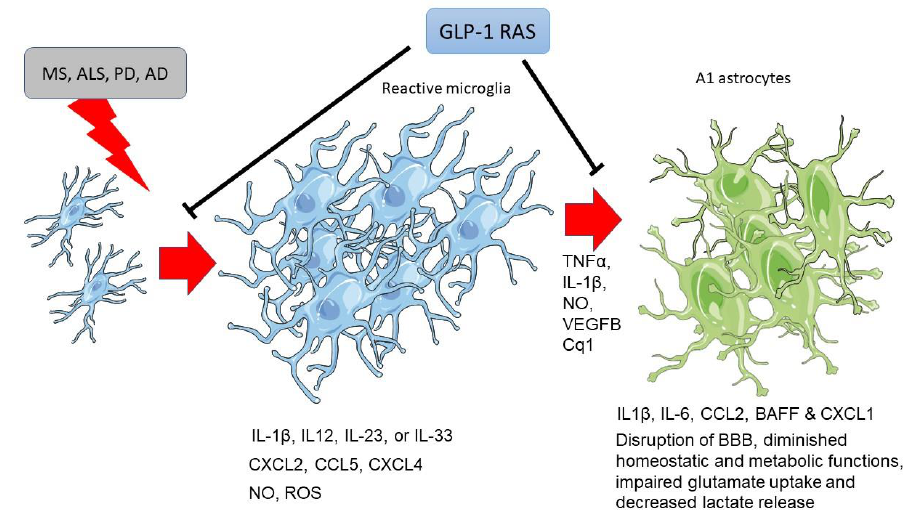
Figure 3. Microgliosis and astrocytosis induced by neurodegenerative diseases are blocked by